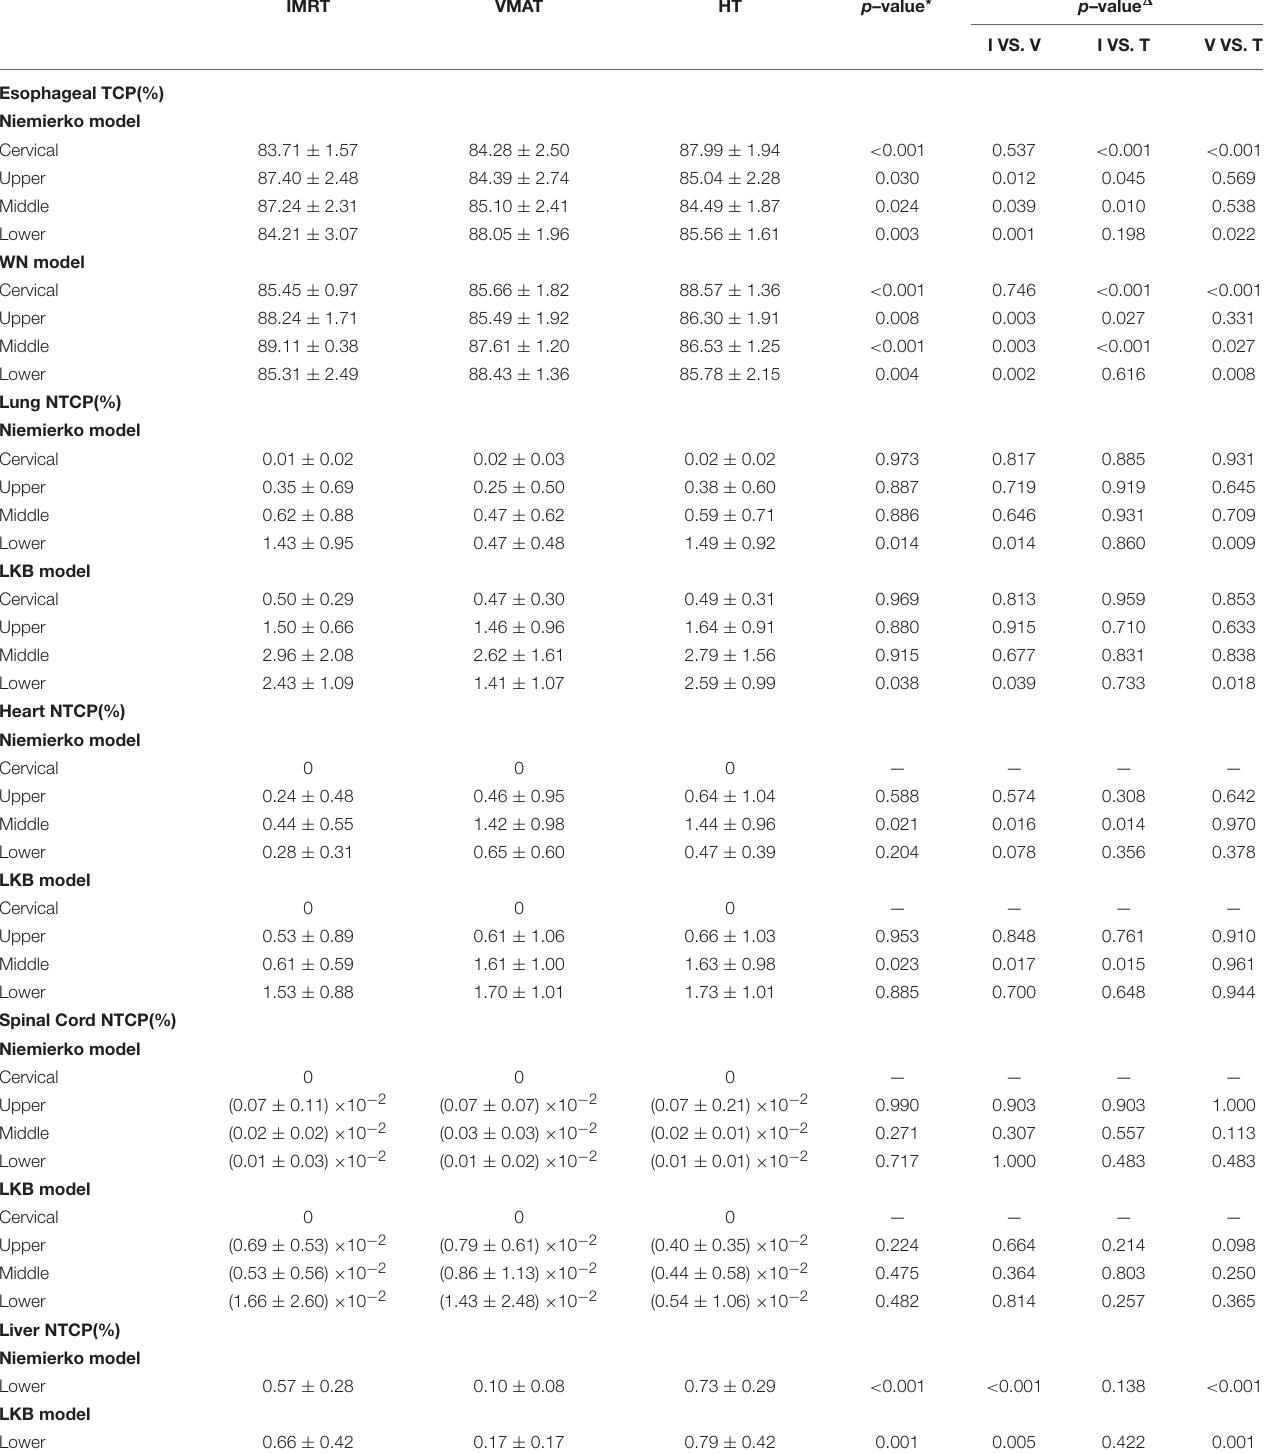
TABLE 5 | The results of TCP for EC and NTCP for OARs. IMRT